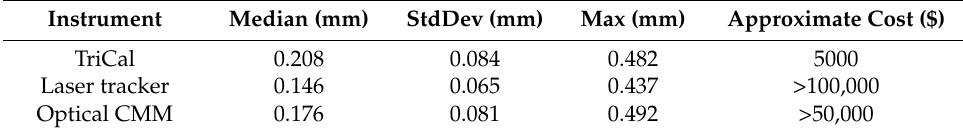
Table 8. Comparison of TriCal with other calibration